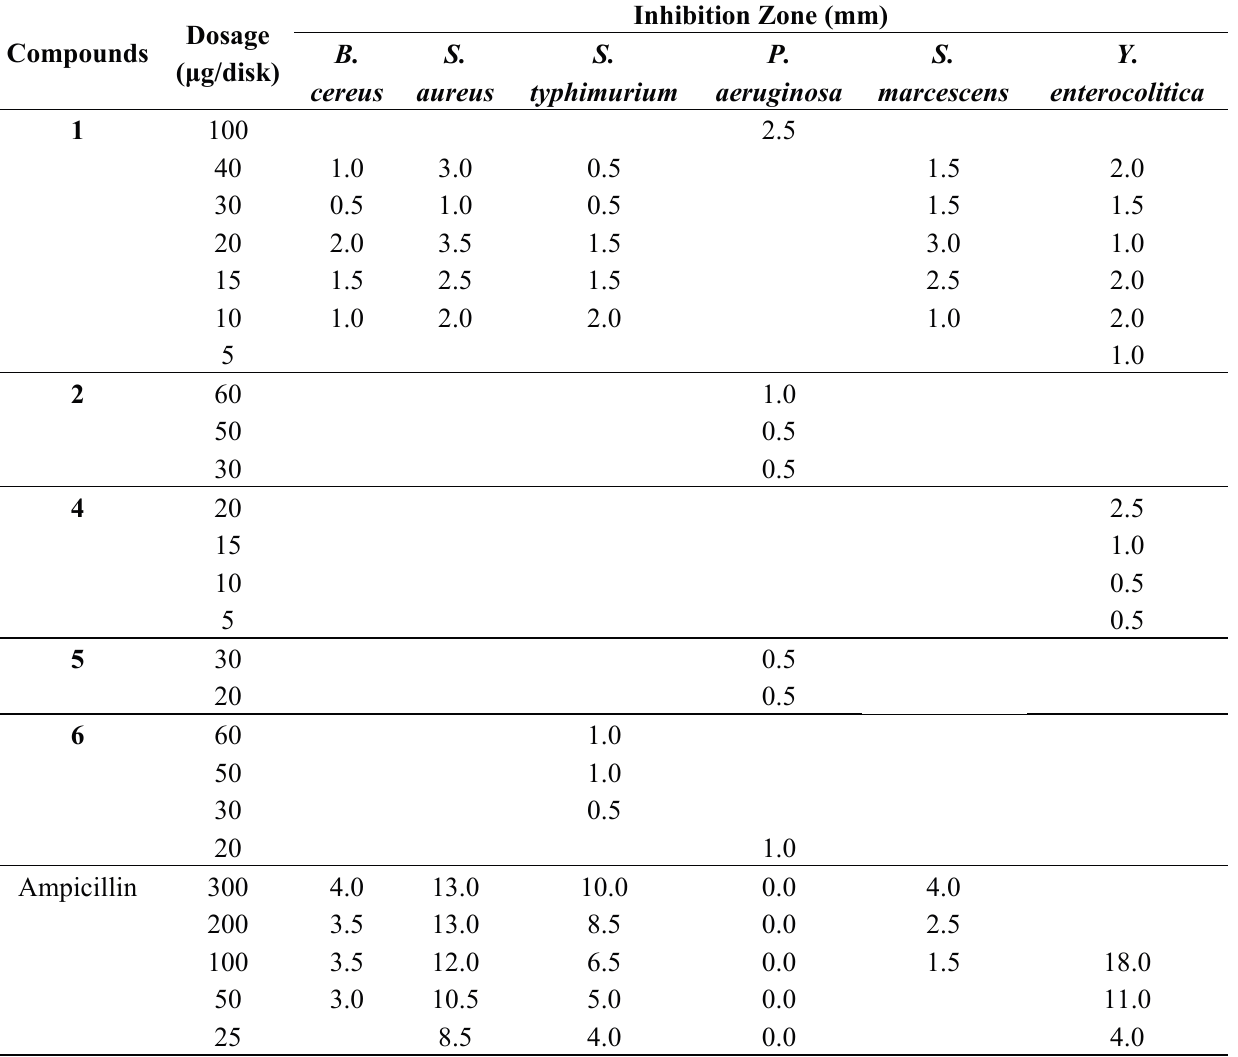
Table 3. Antibacterial activity (zone of inhibition in mm) of compounds 1 , 2 and 4 – 6 .